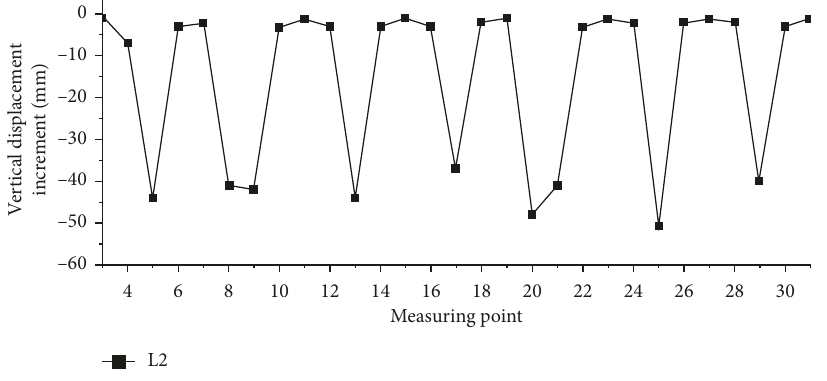
Figure 10: Observation results of vertical displacement of line